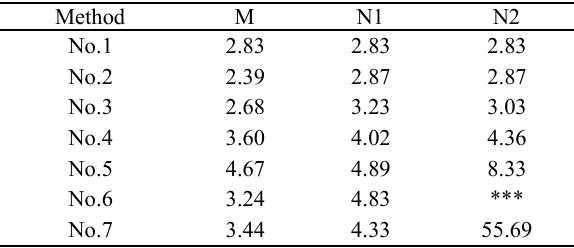
Table 5. The comparison of M, N1 and N2 in dataset ( pixels ) As shown in Table 5, No.1 is the starting image, the registration accuracy is 2.83 pixels using method M. The number of matching points in No.1-6 pair less than 6, so this registration is failure with method N2. The registration error of No.7 is 55.69 pixel with method N2, which is much large than method M (3.44 pixel ) and N1 (4.33 pixel ), the reason is that No.1-7 pair spacing is too large and no enough correct matching points. Therefore, excluding No.1, No.6 and No.7, the average registration errors of No.2-